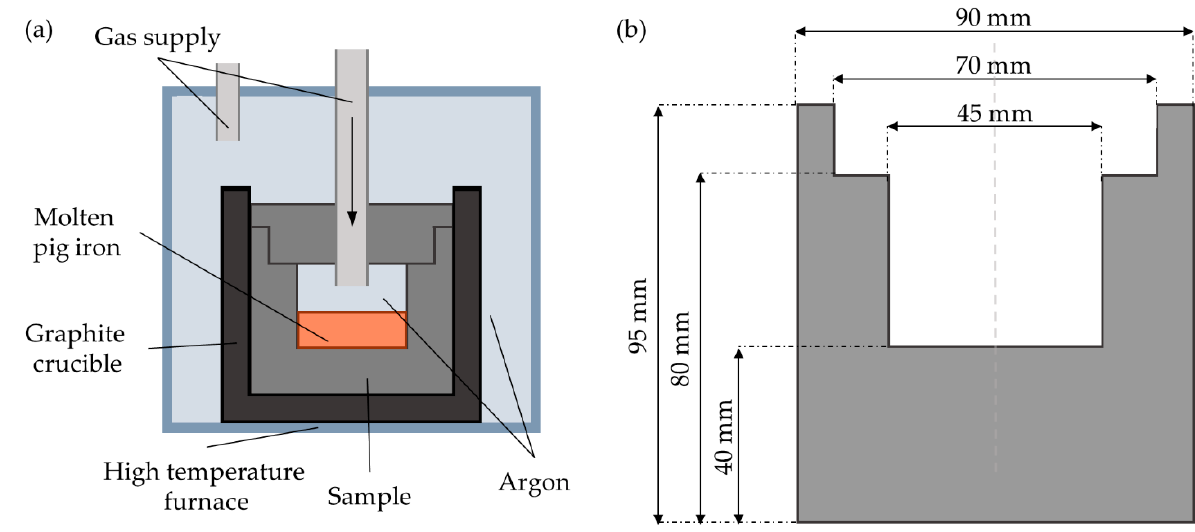
Figure 1. Hot metal penetration test: ( a ) scheme of HMP test and ( b ) dimensions of the HMP crucible. Table 1. Chemical composition of crude iron used in the HMP test. Crude Iron Composition [wt.%]